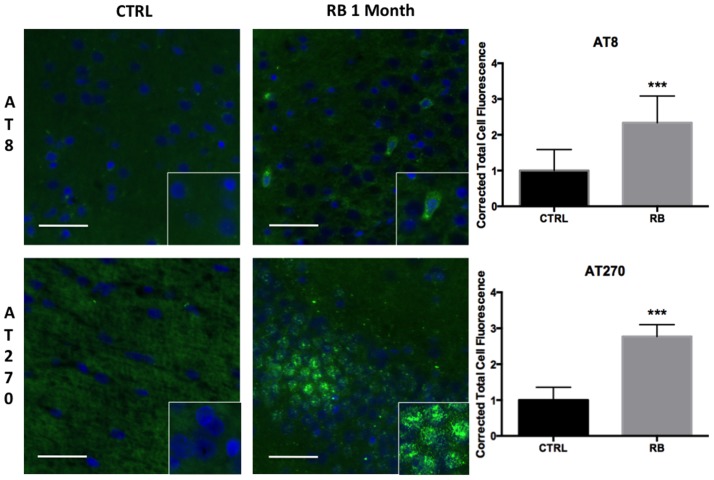
Tau hyperphosphorylation is seen in microfoci throughout the contralateral superficial cortex. AT8 was significantly increased at 1 month post repetitive blast (t = 4.455, p < 0.001). AT270 was also significantly increased following repetitive blast (t = 11.47, p < 0.001). AT270 was increased in a circular distribution. Tau hyperphosphorylation is an indicator of progressive pathology. Values were calculated using a student’s t-test comparing the mean difference between groups.